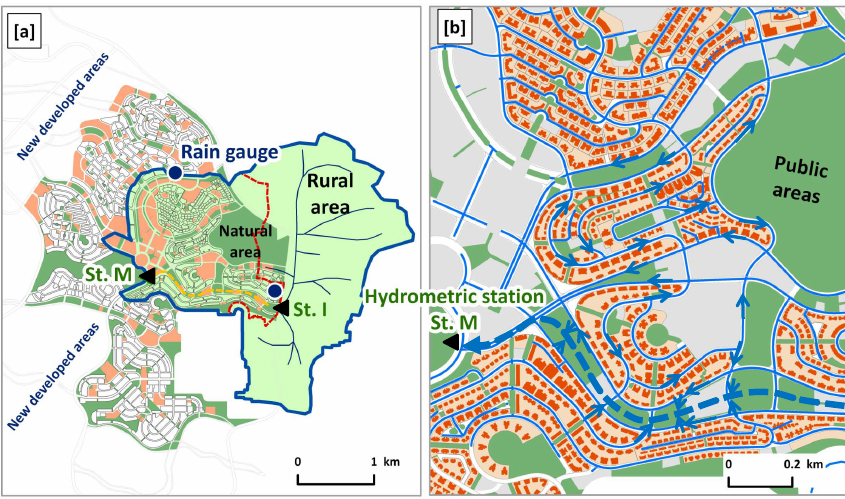
Fig. 3. (a) The city of Modiin and the hydrometeorological setup. Flow from the rural area upstream the town is measured by Station I (St. I). Station M (St. M) at the town outlet measures both the rural area (measured by St. I) and urban areas. One raingauge is located outside the map area; (b) Zoom into the urban center. Blue lines indicate flow lines of urban runoff: surficial on roads and subsurface culverts.